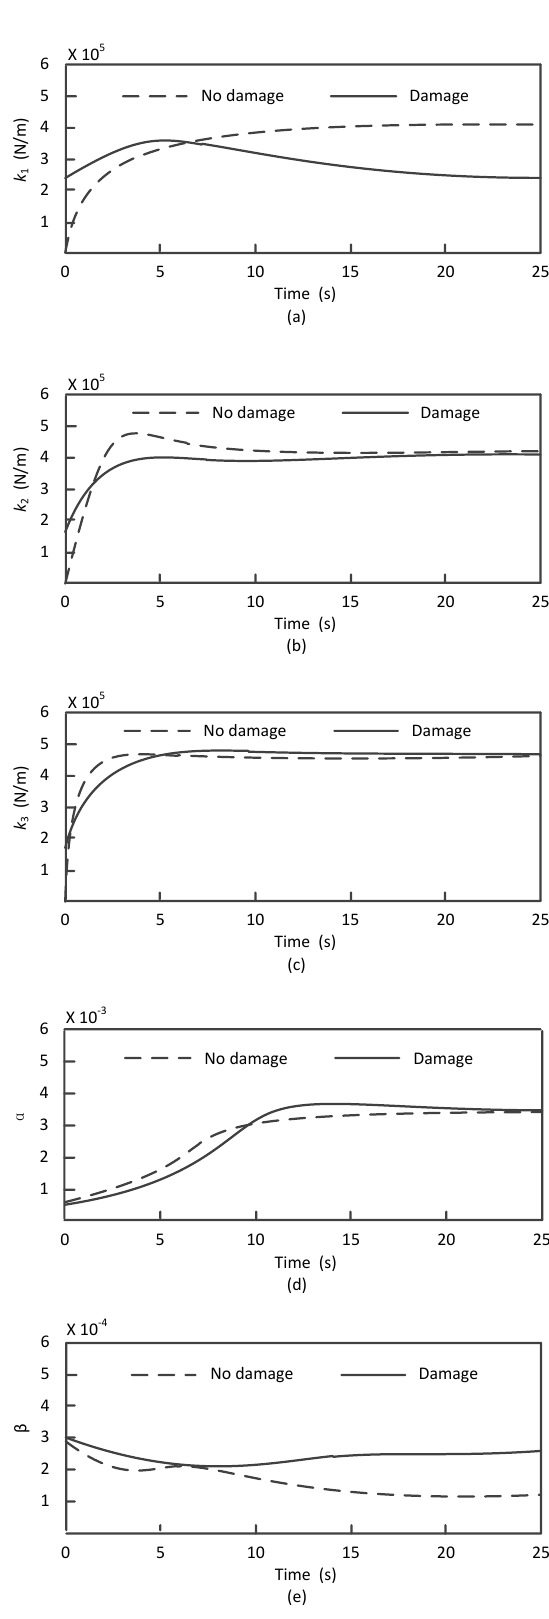
Figure 6. Identification of the frame’s structural parameters in the case of damage on Column 2: ( a ) recognition results of k 1 , ( b ) recognition results of k 2 , ( c ) recognition results of k 3 , ( d ) recognition results of α and ( e ) recognition results of β